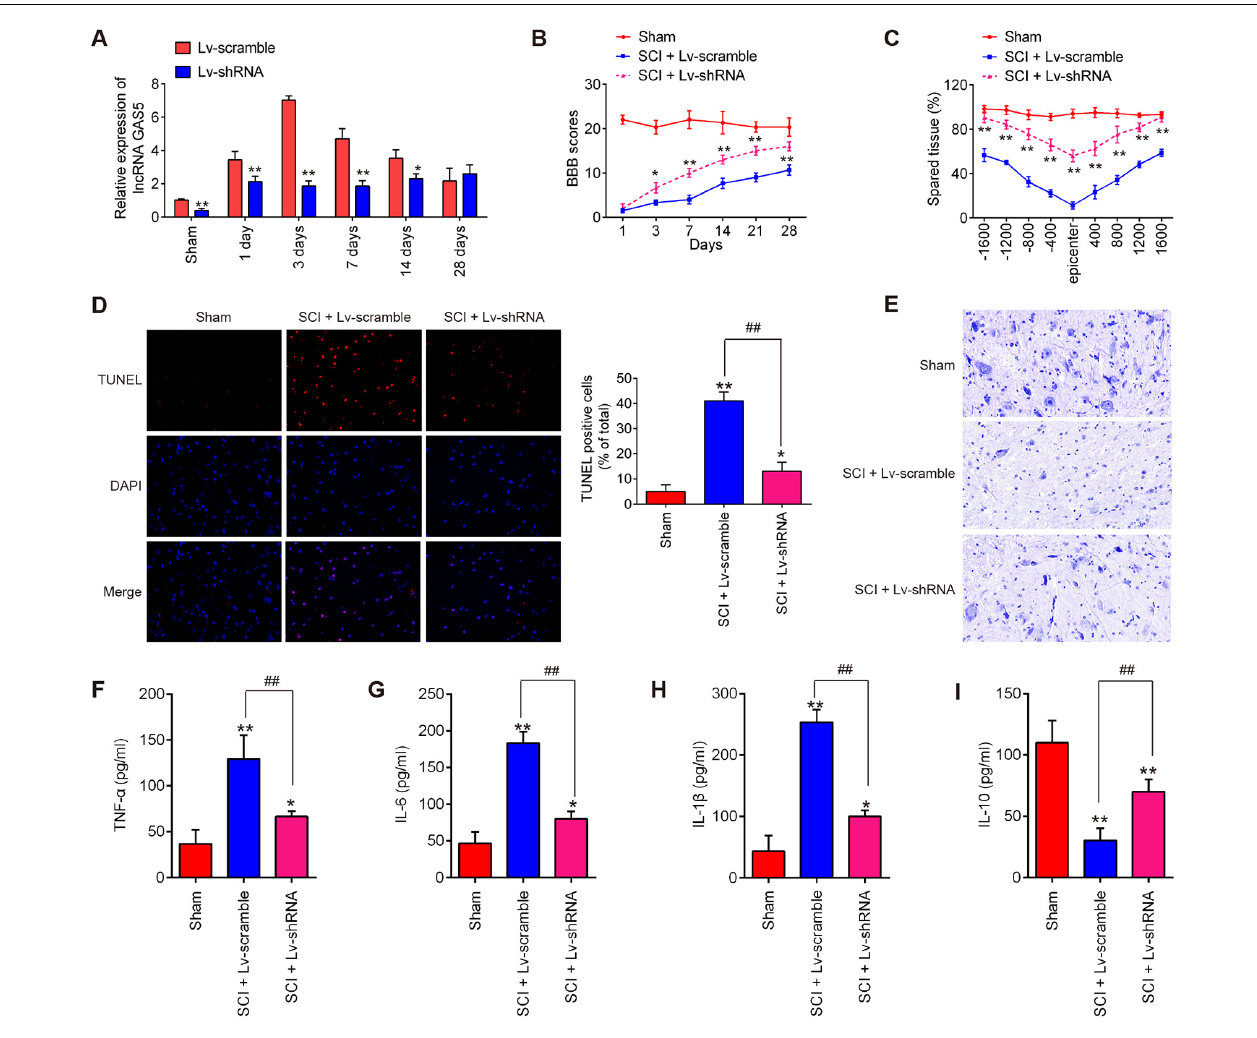
FIGURE 2 | Knockdown of long noncoding RNA (lncRNA) GAS5 improves recovery of SCI mice by reducing apoptosis and inflammation. (A) Results of quantitative reverse transcription polymerase chain reaction (qRT-PCR) on expression levels of LncRNA GAS5 in spinal cord tissues 1, 3, 7, 14, and 28 days after lentivirus short-hairpin RNA (LV-shRNA) injection ( n = 10 per group). (B) Basso, Beattie, and Bresnahan (BBB) score 1, 3, 7, 14, 21, and 28 days after SCI for all groups of mice ( n = 10 per group). (C) Lesion analysis at the rostral ( − ) and caudal (+) margins from the lesion epicenter after cresyl violet staining 14 days after the SCI ( n = 10/group/time). (D) Apoptosis determined using the terminal deoxynucleotidyl transferase dUTP nick end labeling (TUNEL) assay. (E) Representative images of Nissl staining of the spinal cord (magnification 400 × ). (F–I) Results of enzyme-linked immunosorbent assays (ELISA) on tumor necrosis factor (TNF)- α , interleukin (IL)-6, IL-1 β , and IL-10 in spinal cord tissue grinding fluid from mice at 3 days post SCI ( n = 10 per group). Data represent the mean ± SD of three independent experiments. * p < 0.05, ** p < 0.01 vs. sham group; ## p < 0.01 vs. SCI + LV-scramble